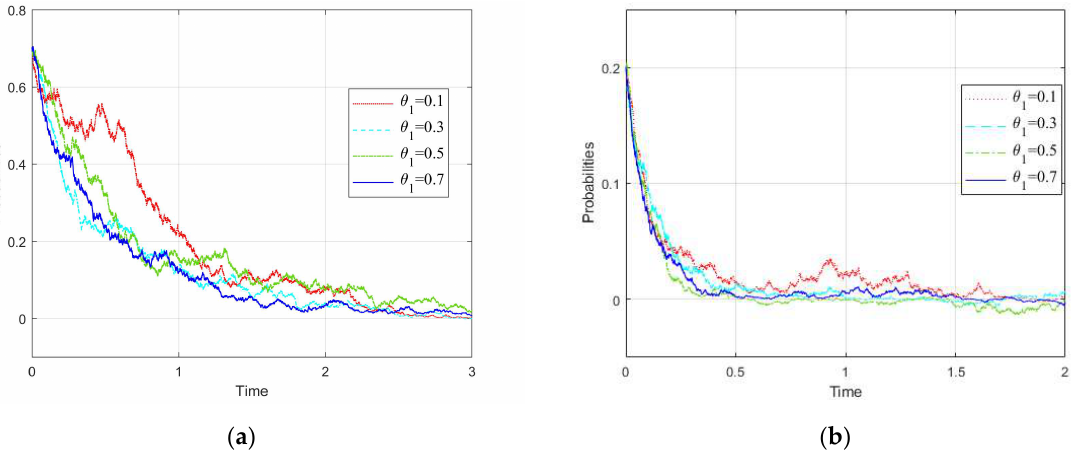
Figure 3. Influence rule of changes of θ 1 on Branch Government 1: ( a ) influence rule of changes of θ 1 on Branch Government 1 when x (0) = 0.7, y (0) = 0.7, z (0) = 0.7, and ( b ) influence rule of changes of θ 1 on Branch Government 1 when x (0) = 0.2, y (0) = 0.2, z (0) =